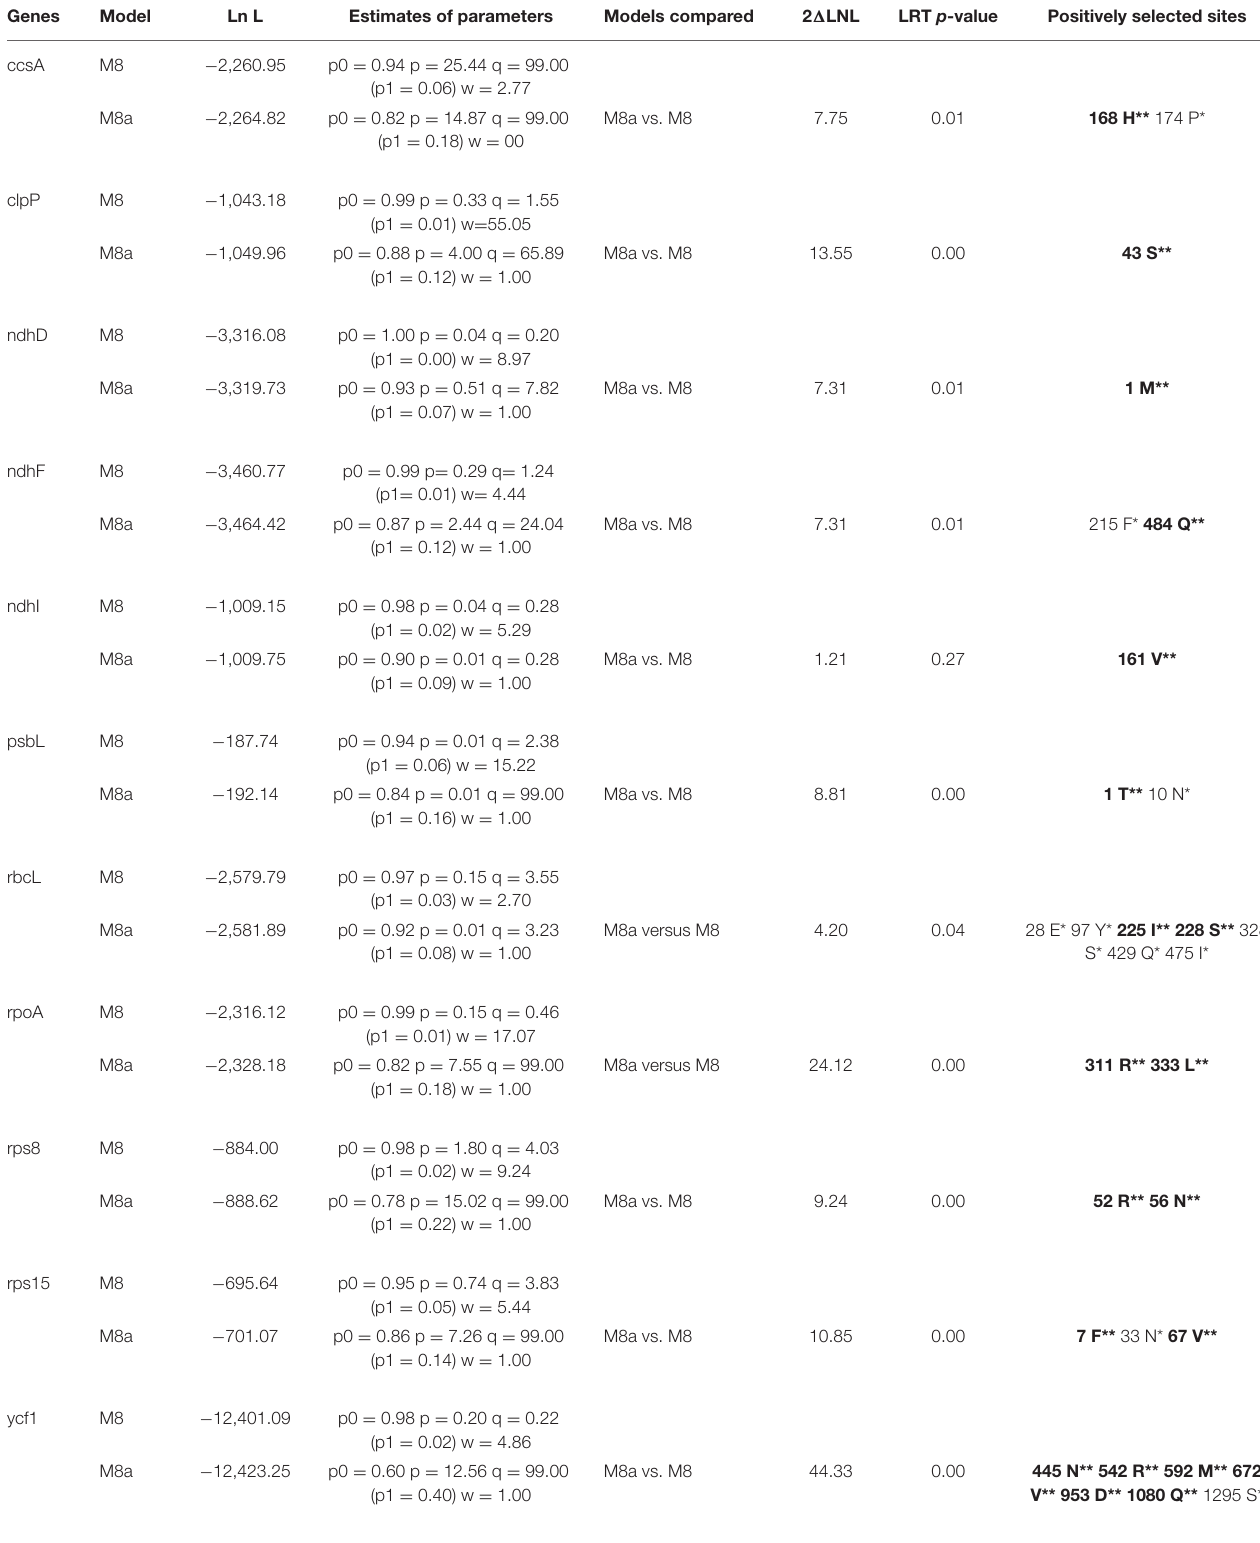
Posterior probability values were assessed with both Naive Empirical Bayes (NEB) and Bayes Empirical Bayes (BEB) approaches. * Denotes positively selected sites supported by either NEB or BEB method (p < 0.05). ** Denotes positively selected sites supported by both NEB and BEB methods (p <